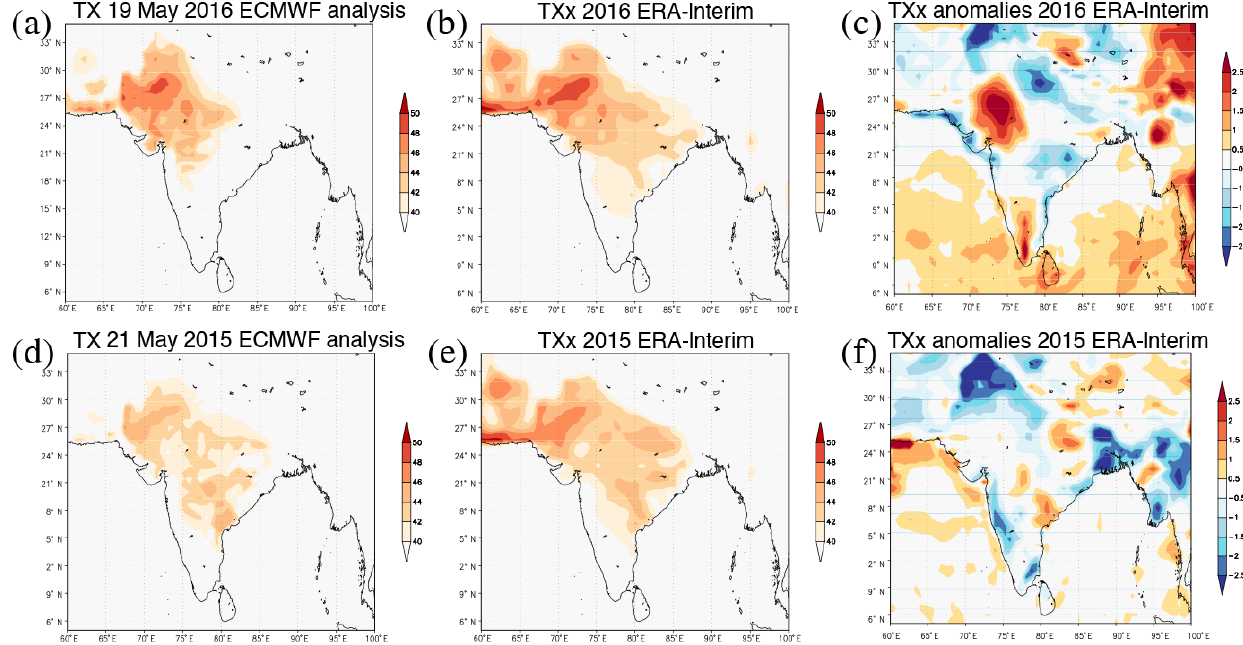
Figure 1. (a) ECMWF operational analysis of the daily maximum temperature on 19 May 2016 ( ◦ C); (b) ERA-Interim highest maximum temperature of the year, TXx, in 2016 ( ◦ C); (c) anomalies of TXx in 2016 relative to 1981–2010 (K). (d–f) Same as (a–c) but for 21 May 2015, showing the heat wave in Andhra Pradesh and Telangana in